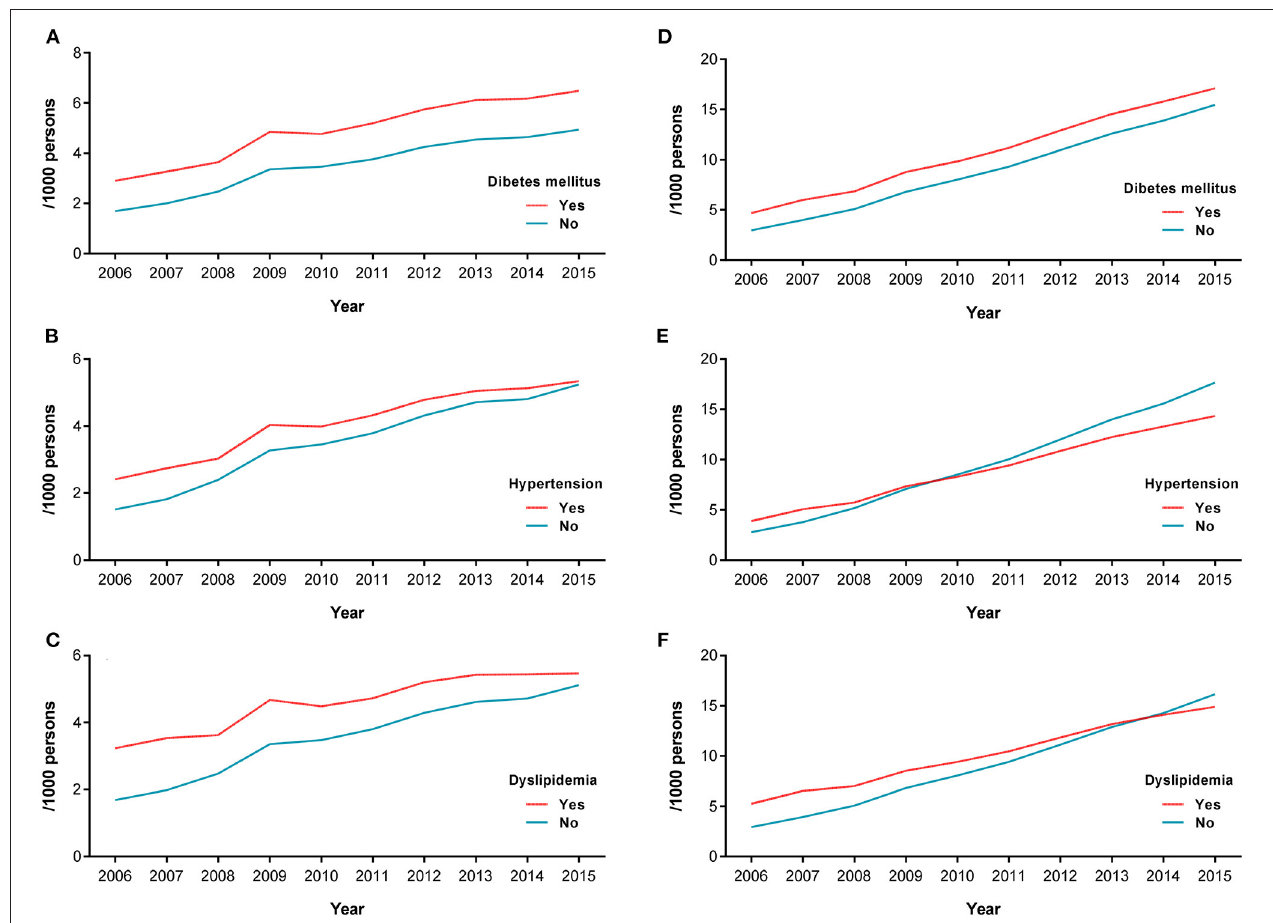
FIGURE 2 | Annual incidence rate of AD in vascular disease subgroups. Incidence (A) and prevalence (D) of AD in the diabetes mellitus subgroup. Incidence (B) and prevalence (E) of AD in the hypertension subgroup. Incidence (C) and prevalence (F) of AD in the dyslipidemia subgroup. AD, Alzheimer’s